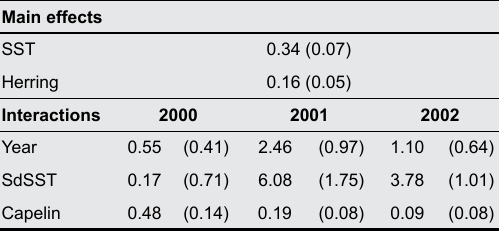
Table 4. Estimates (and SE) of variables in selected model describing minke whale distributions within the study area in 2000, 2001 and 2002. Residual deviance=446.95 (Null devi- ance=528.19), residual DF=695.